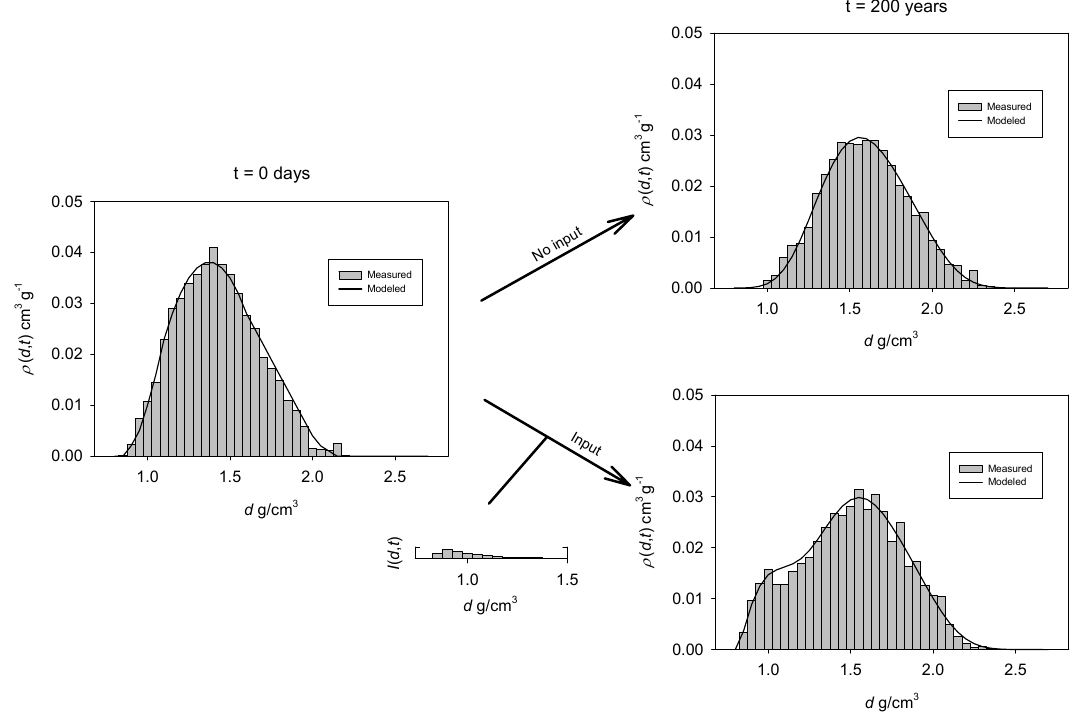
Fig. 2. Constructed example of a model application where a density ( d) distribution of SOC is measured on a soil at time 0 years (left) and again after 200 years of treatment with or without inputs of organic matter (right). A continuous distribution model is used to describe the of the distribution, and the parameters of the model are optimized to make the distribution fit the observed data (see text for